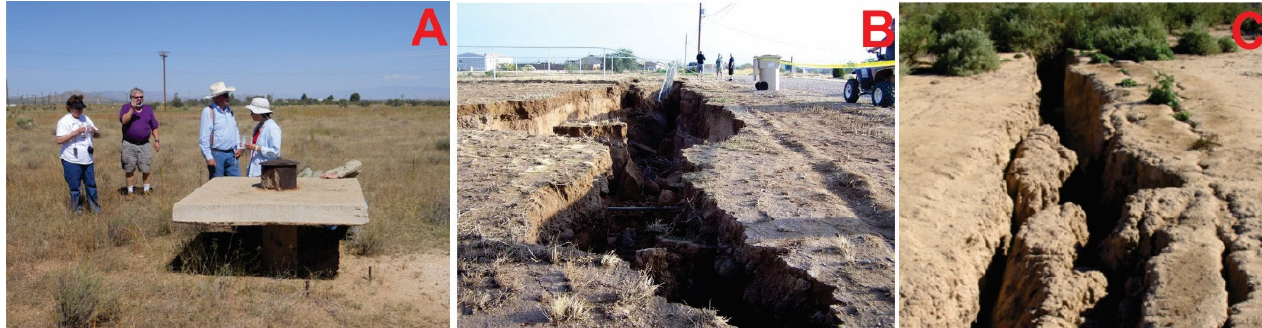
Figure 5. The effects of land subsidence in the area of Arizona. ( A ) Max vertical deformation reached 75 cm between 1940–1950 [79] . ( B ) Surface ruptures were reopened after a major rain in